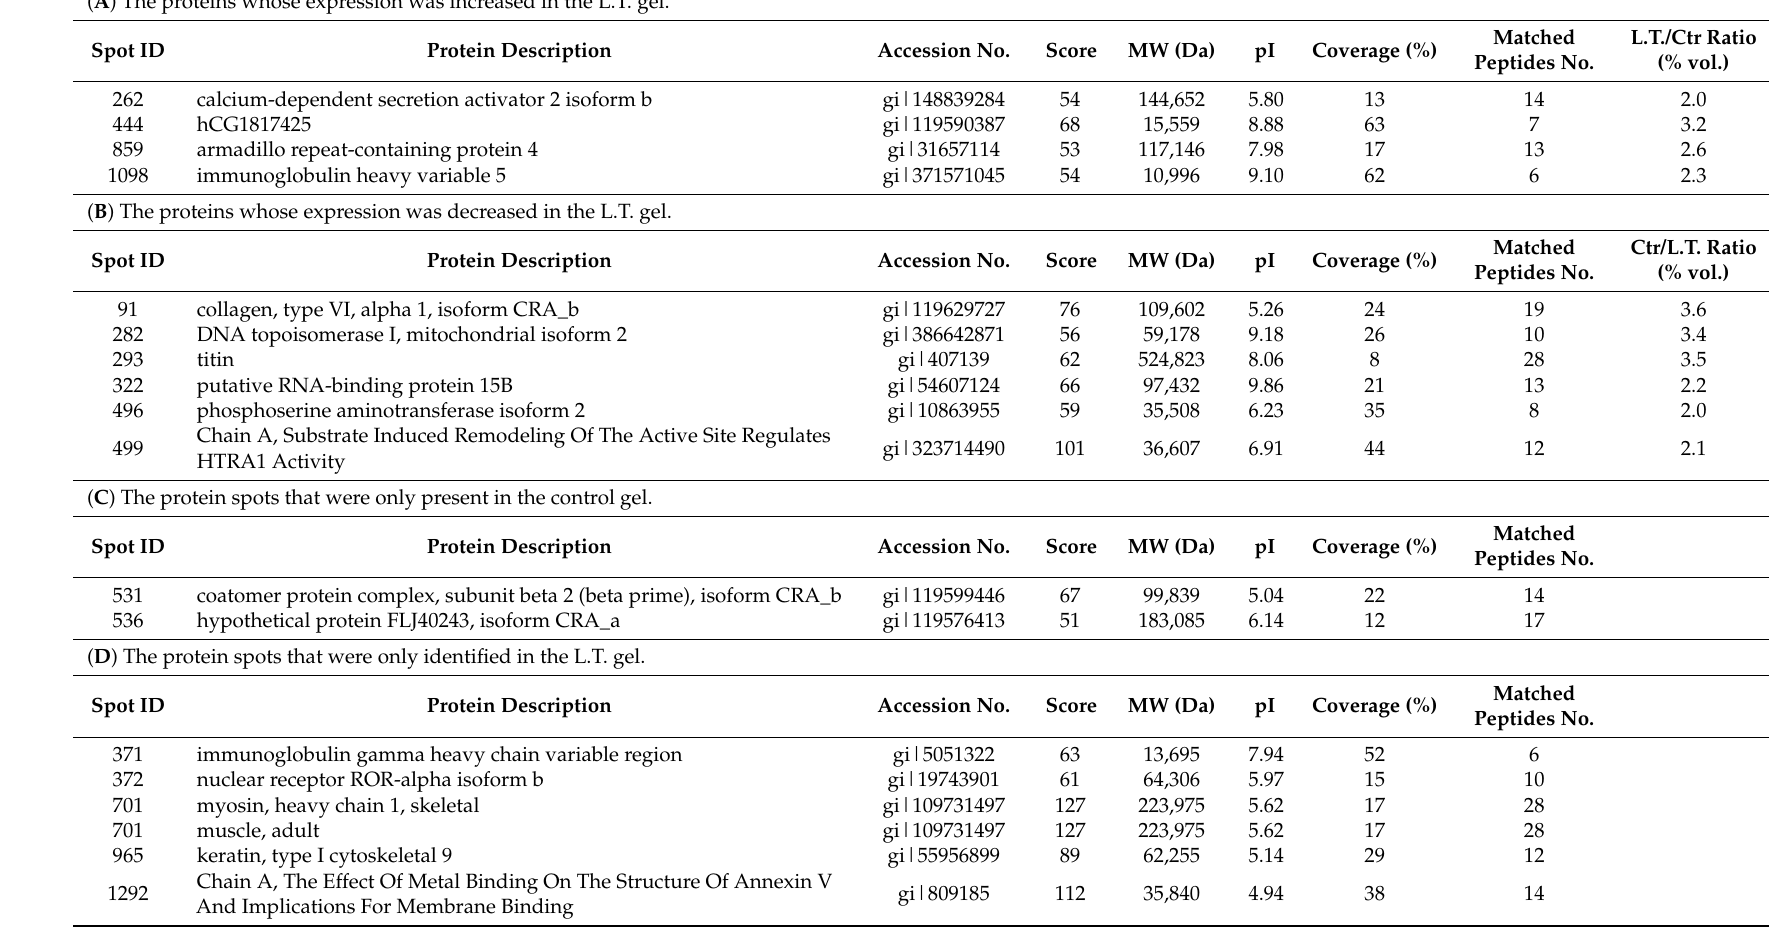
Table 1. Exosomal proteins identified by MALDI-TOF-MS for each protein described in Figure